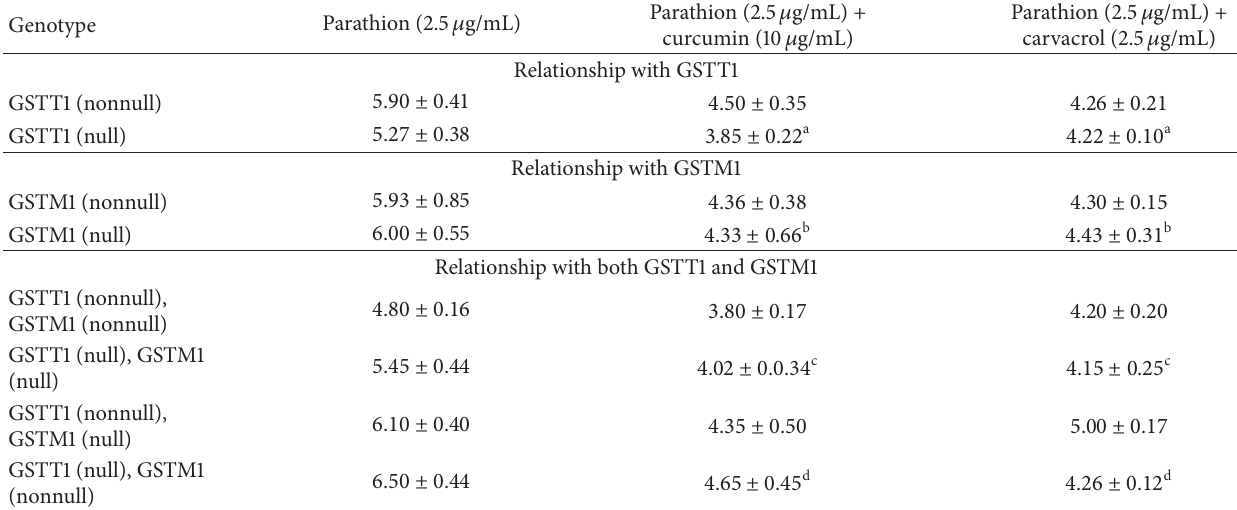
Table 5: Effect of GSTT1 and GSTM1 polymorphism on antigenotoxicity of curcumin and carvacrol against parathion induced genotoxicity.